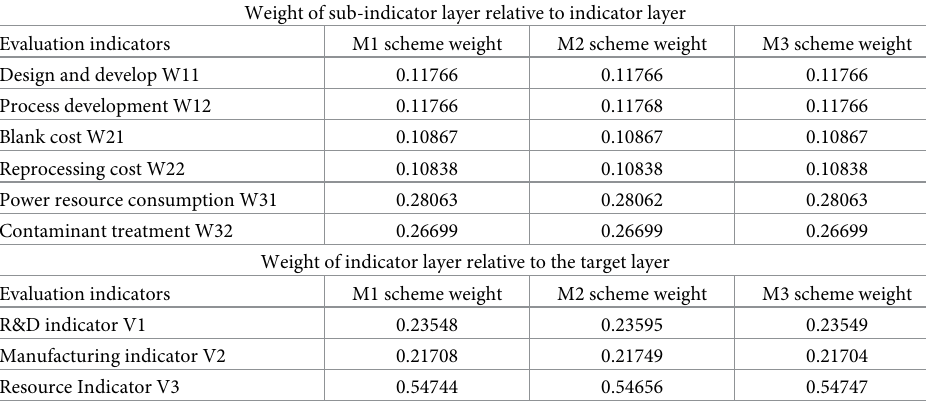
Table 7. Analysis matrix of the ECS scheme (objective). Weight of sub-indicator layer relative to indicator layer